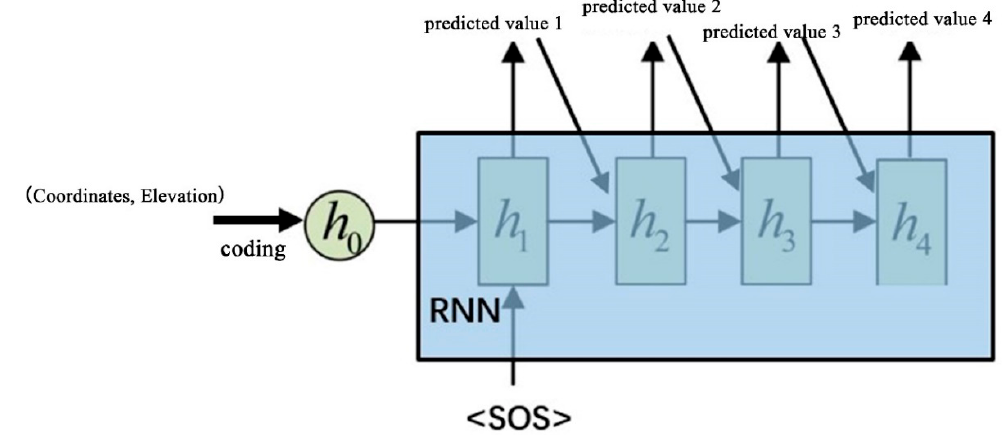
Figure 2. Schematic diagram of the stratum type model.